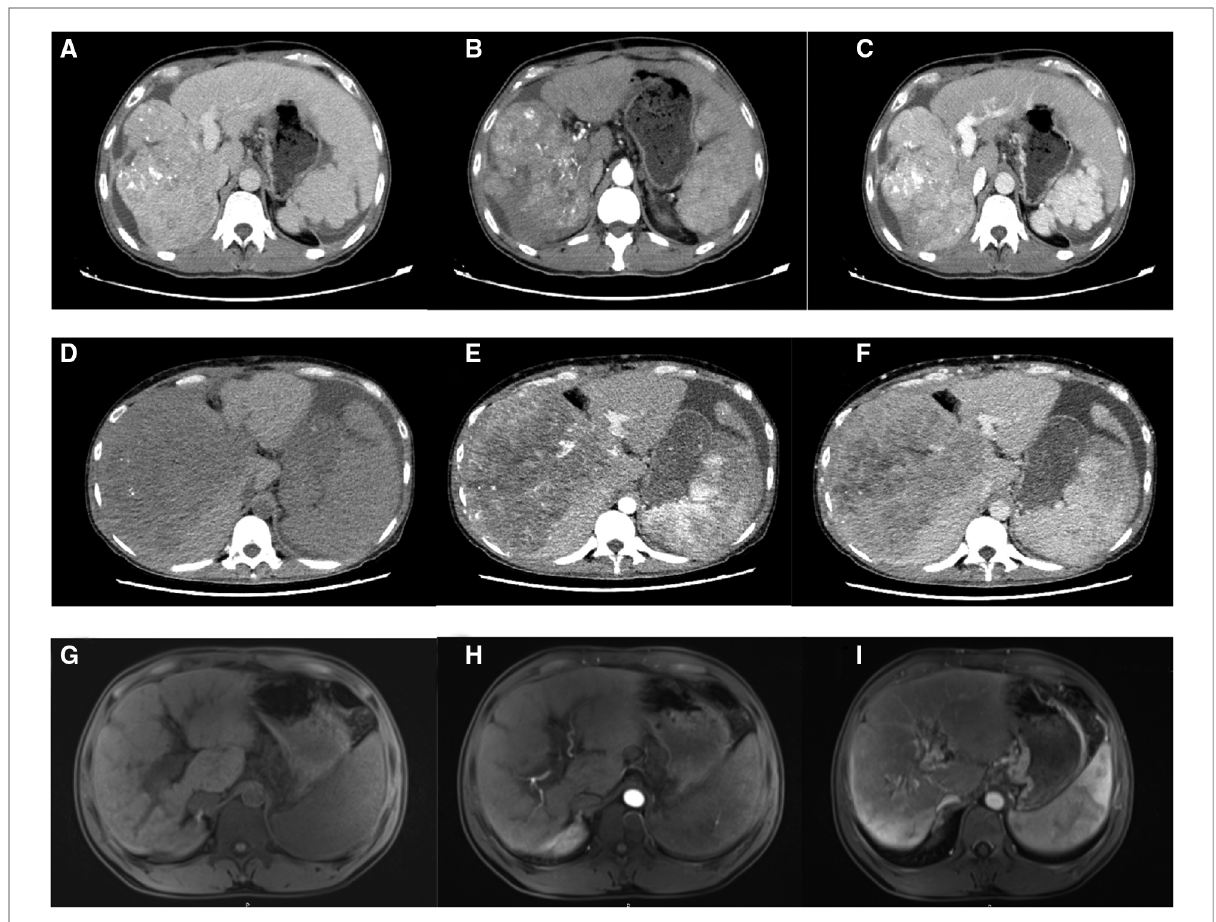
FIGURE 3 Postoperative CT images of case 1: unenhanced phase ( A ), arterial phase ( B ), and venous phase ( C ); postoperative CT images of case 2: unenhanced phase ( D ), arterial phase ( E ), and venous phase ( F ); and postoperative MRI images of case 3: unenhanced phase ( G ), arterial phase ( H ), and venous phase ( I